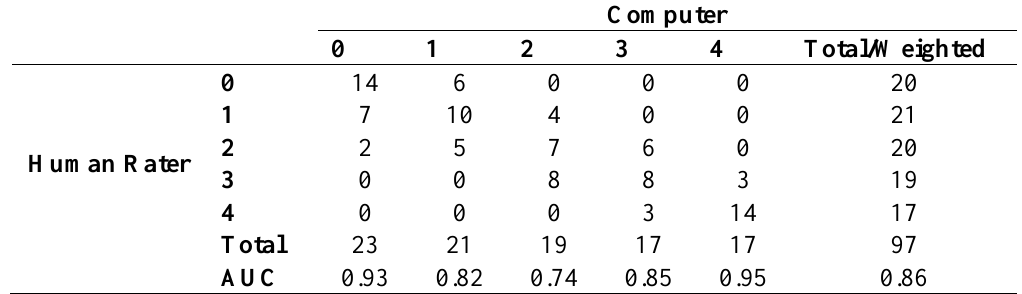
Table 3. Assessments of GTS for the computer method and human rater. The computed scores are derived after applying 10-fold cross validation on the logistic regression